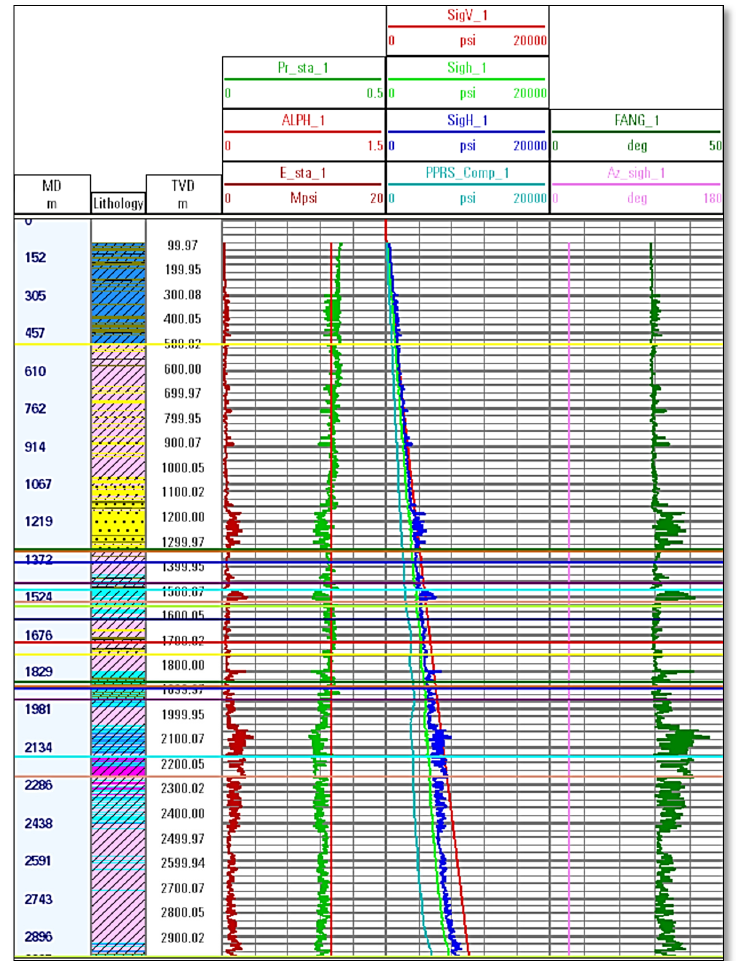
Figure 3. ( top ) Various elastic parameters for Well ‐ 1 after predicting the DTS ; First track is showing: DT and DTS in μ s/ft along with RHOB (density) in g/cc, Second track is showing: Dynamic and static Young’s modulus in MPsi, Third track is showing: Dynamic and static Poisson’s Ratio along with Biot’s coefficient, Forth track is showing: Dynamic and static Bulk and shear Modulus in MPsi. ( bottom ) in ‐ situ stresses of Well ‐ 1. The first track is showing: Poisson’s Ratio, Biot’s coefficient and Young’s modulus, the second track is showing: Vertical stress, minimum horizontal stress, maximum horizontal stress along with the pore pressure, the third track is showing friction angle and horizontal stress azimuth.